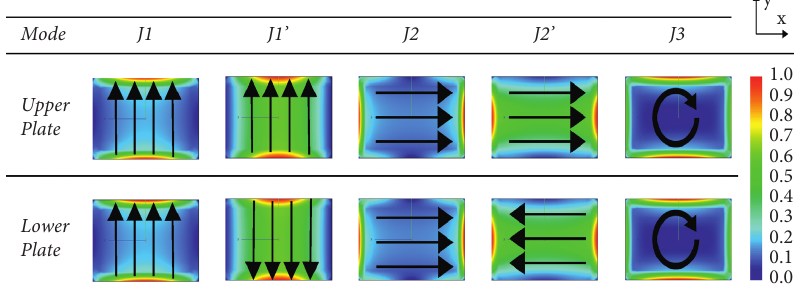
Figure 4: Current distribution associated to the first five modes of the structure shown in Figure 2, at the resonance frequency of each mode.